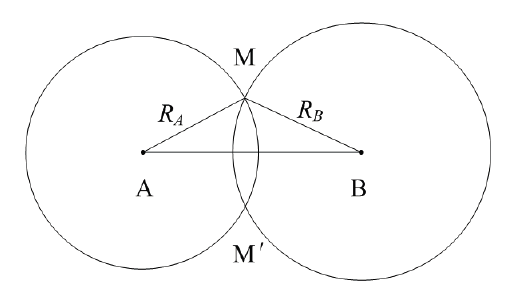
Figure 1. Geometrical principle of the TOA